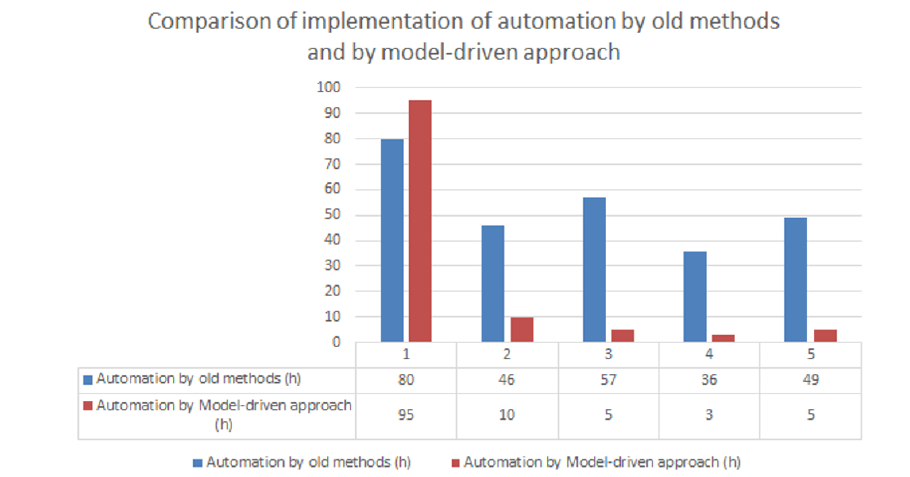
Fig. 8. Use case for a model-driven